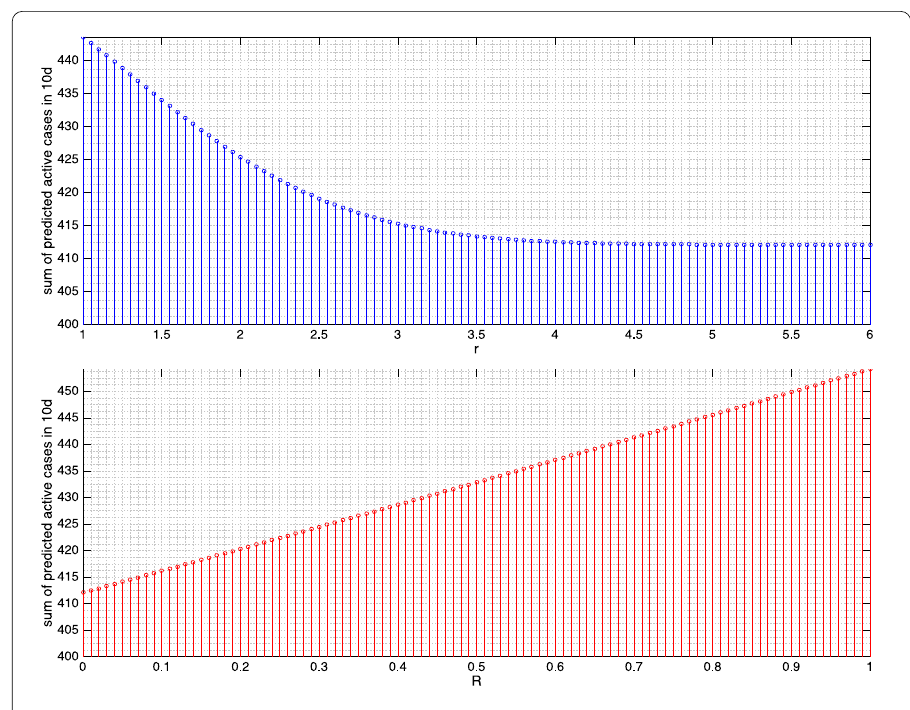
Figure 6 Sum of the predicted active cases for the next 10d (April 12–21, 2020) in Sri Lanka under variation of r and R . The value r = 4.5 leads to the reduction to 78.90%, R ≈ 1/4,1/3,1/2,3/4 to 93%, 93.73%,95.3%, and 97.63%, respectively